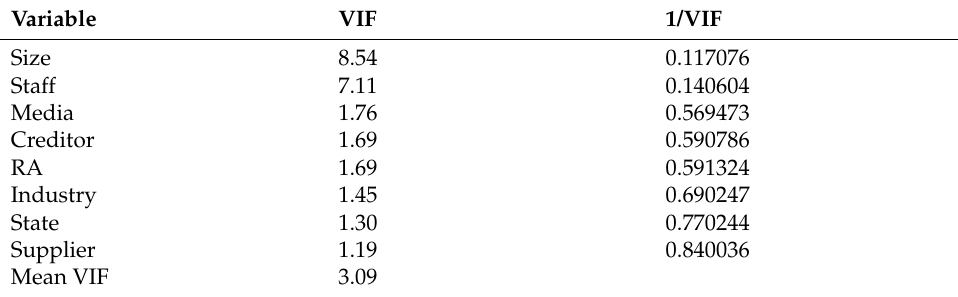
Table 5. Multi-collinearity discriminant